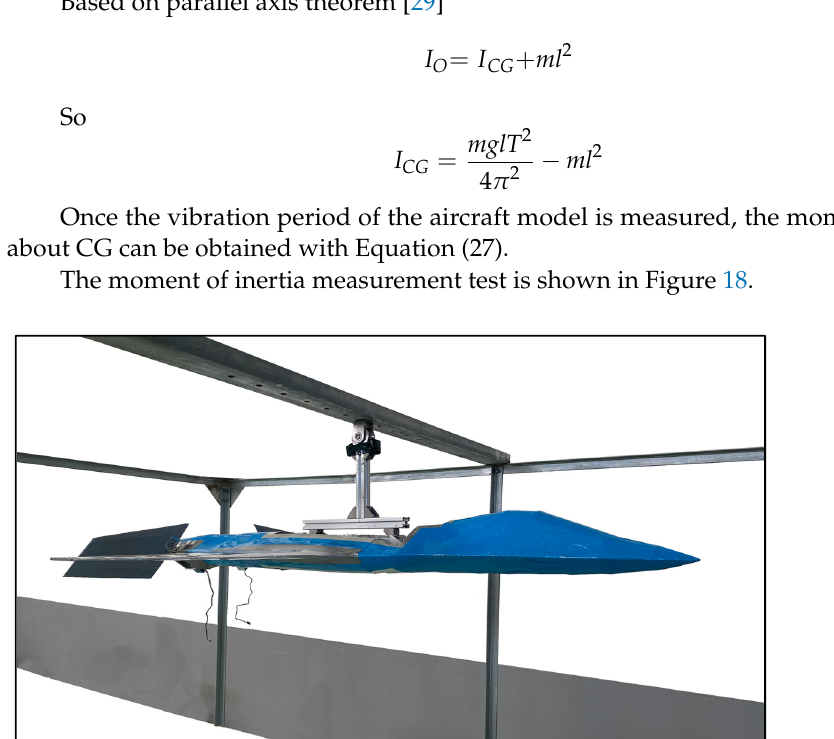
Figure 20. The longitudinal control law. The simulation results are shown in Figure 21. Simulink results (a) and (c) are in good agreement with the semi-physical simulation results (b) and (d), respectively. Due to the delay of control desk measurement, the semi-physical simulation images lag behind the Simulink images by 1.8 s. ( a )